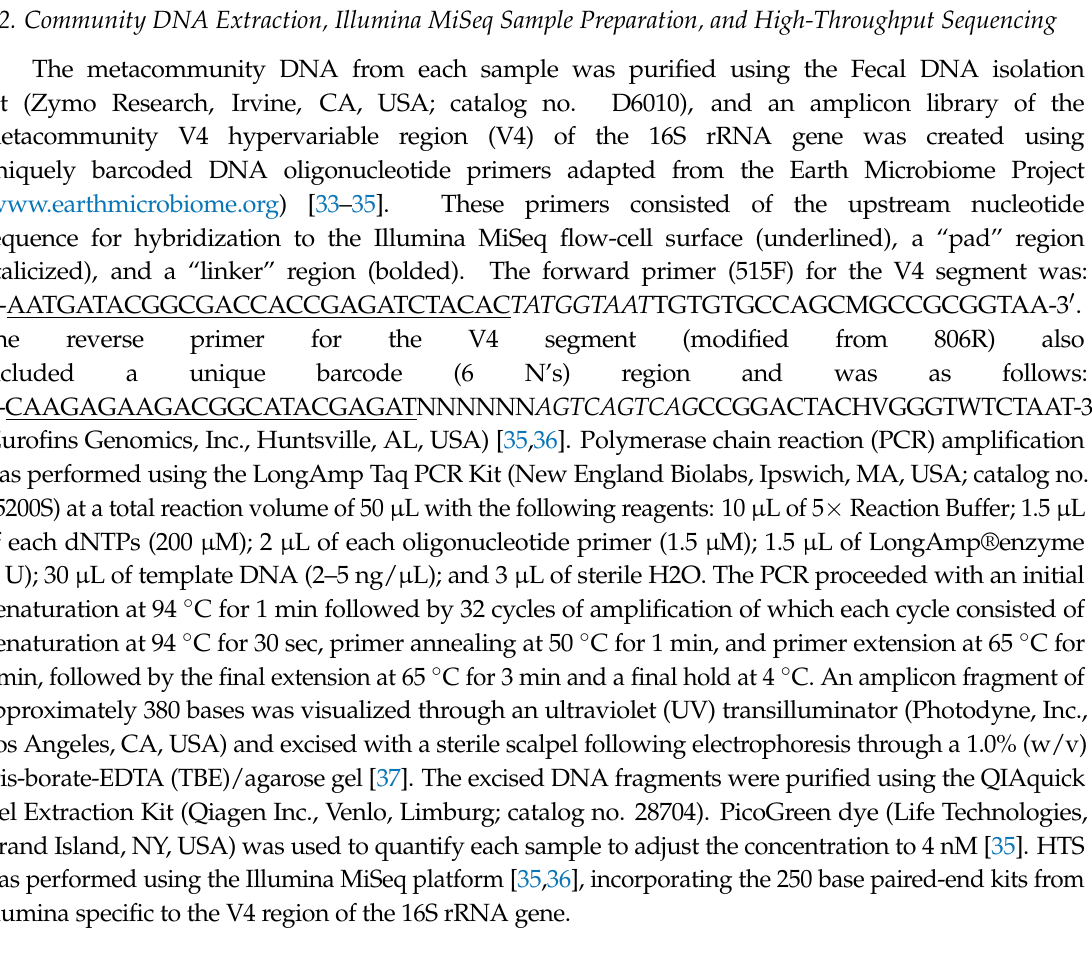
urchins. (C) Sea urchin congregates with the algal food source in view. Photographs by J.B Schram.